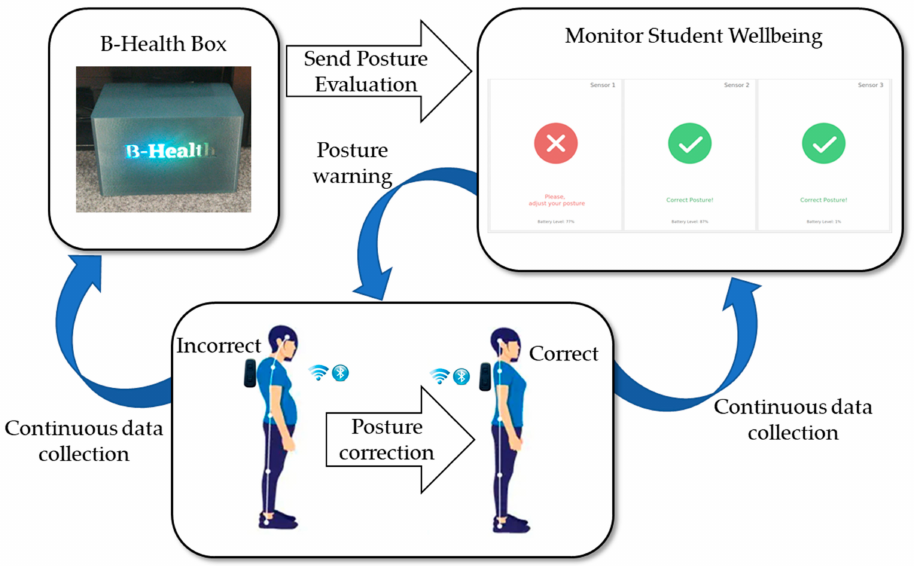
Figure 7. B-Health Box